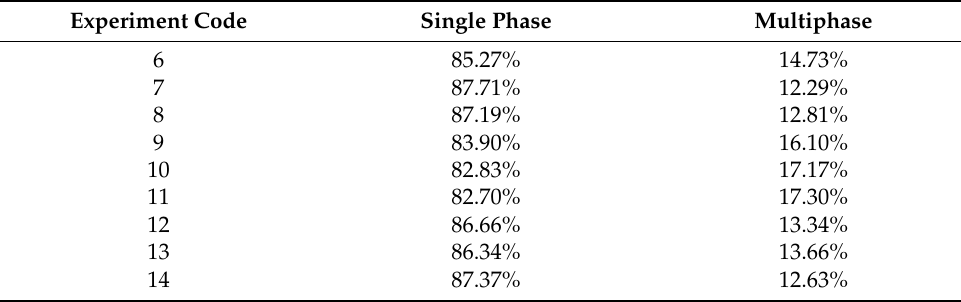
Table 8. Percentage of length in the single-phase stage and multiphase